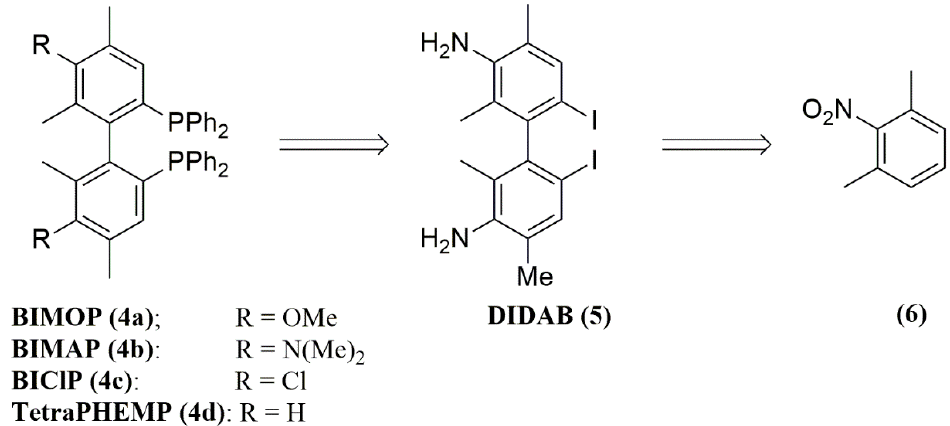
Scheme 1. Retrosynthetic analysis of the biphenyl